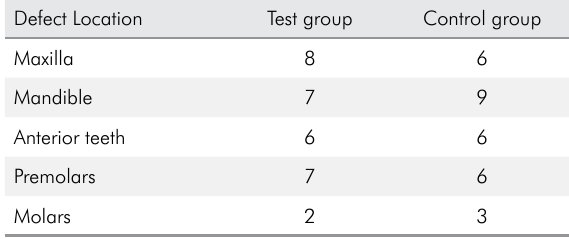
Table 1. Distribution of treated defects (n = 15).